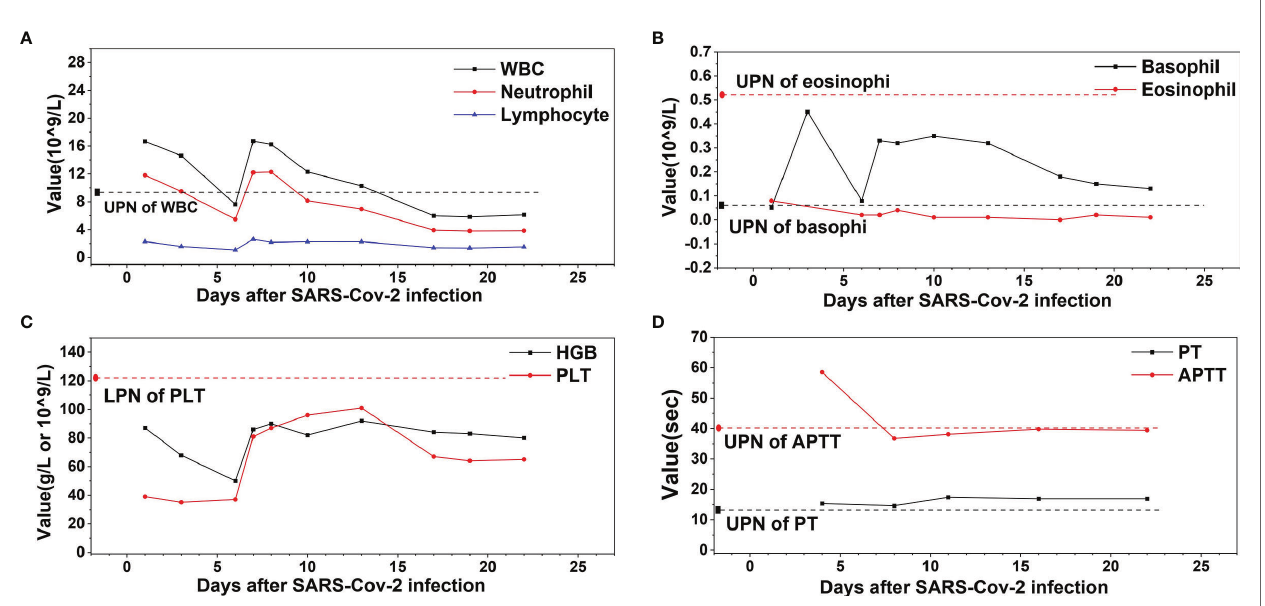
FIGURE 1 | The pro fi le of white blood cell (WBC), hemoglobin (HGB), platelet (PLT), prothrombin time (PT), and activated partial thromboplastin time (APTT) of the patient during the therapy course of COVID-19. (A) WBC, neutrophil, and lymphocyte. (B) Basophil and eosinophil. (C) HGB and PLT. (D) PT and APTT. ULN, upper limit of normal, LLN, lower limit of